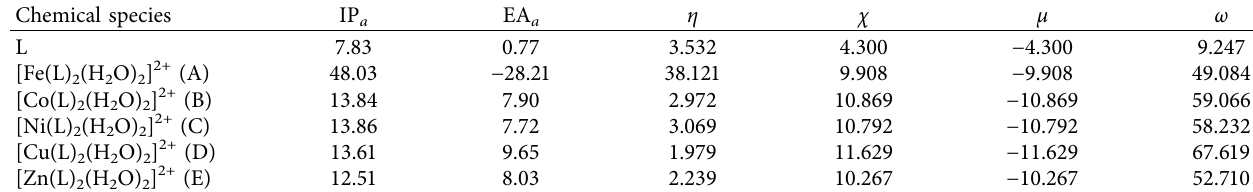
Table 5: Adiabatic ionization potential (IP a ), electron affinity (EA a ), global hardness ( η ), softness ( S ), electronegativity ( χ ), chemical potential ( μ ), and electrophilicity ( ω ) in eV. Chemical